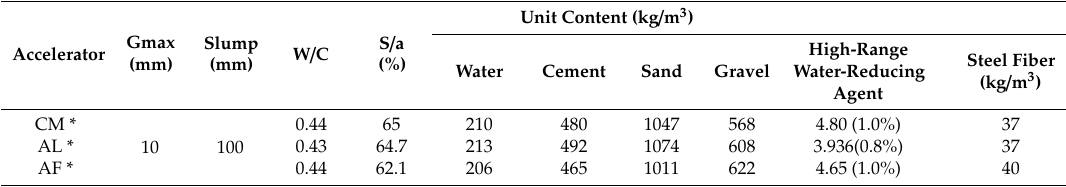
Table 4. Shotcrete performance test mix